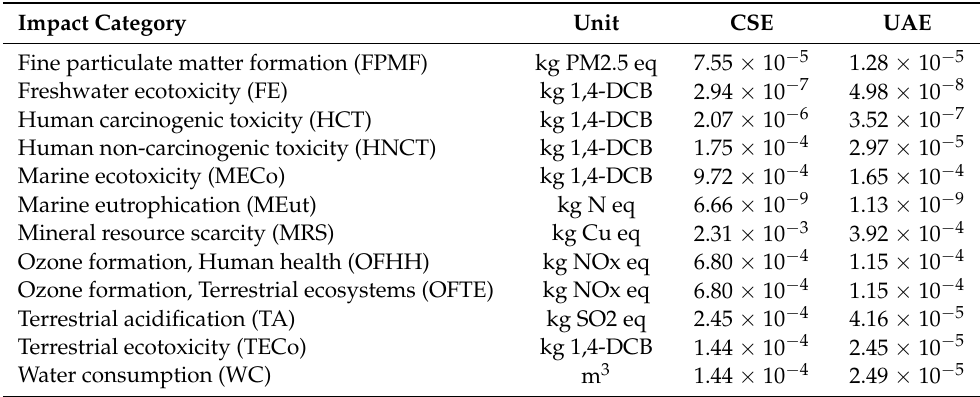
Table 3. Environmental profiles for the extraction processes (per functional unit of 1 g